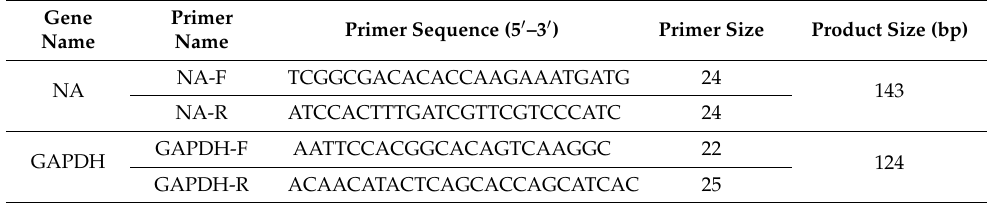
Table 2. Primers of real-time fluorescence